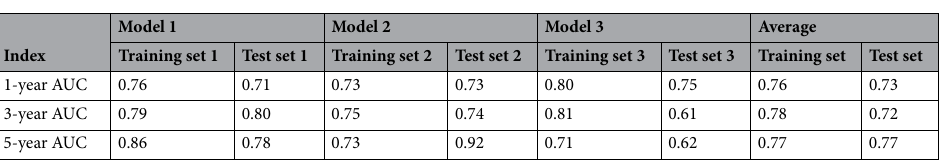
Table 1. The AUC values of three trained